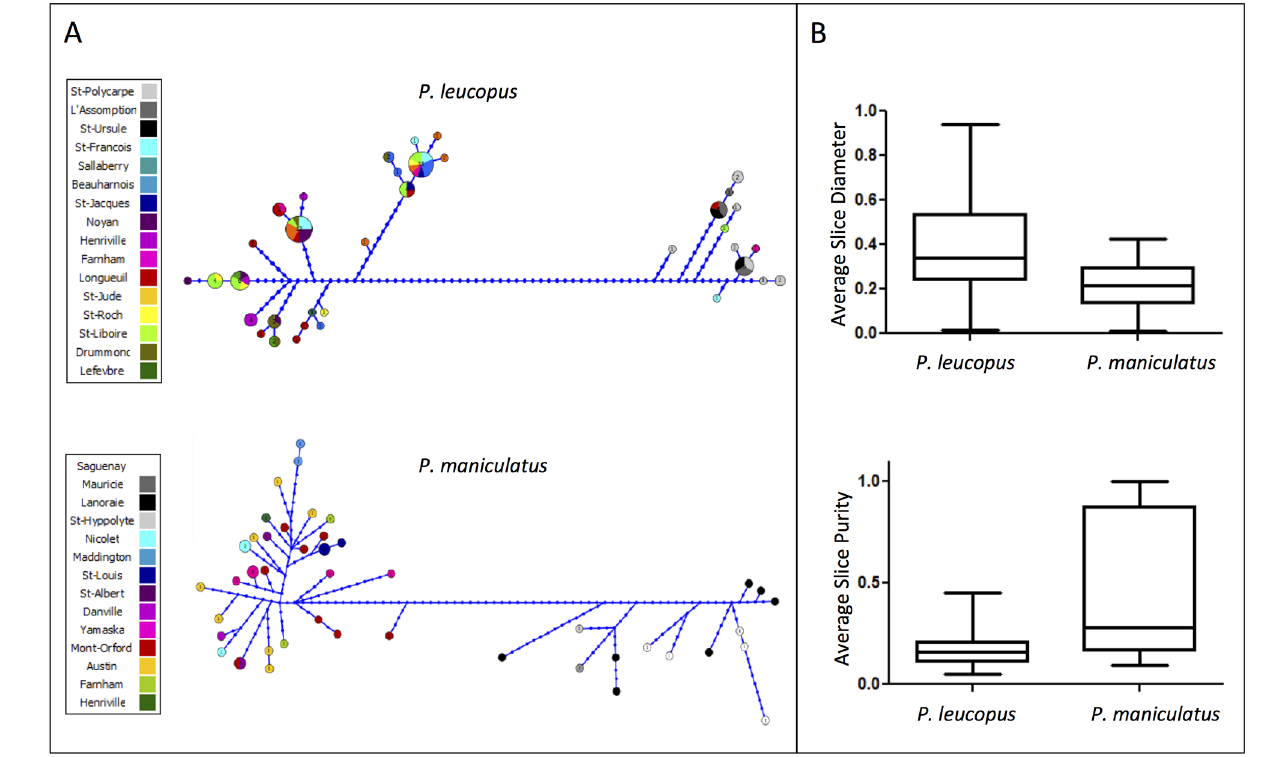
Fig 3. (A) Haplotype networks estimated using the combined sequences of 5 mtDNA regions for P . leucopus and P . maniculatus ; (B) Associated statistics. The colors in the networks correspond to different localities where P . maniculatus and P . leucopus were sampled. For both P . leucopus and P . maniculatus , we displayed the average group (slice) diameter and group purity in the haplotype networks of sampling sites for the five